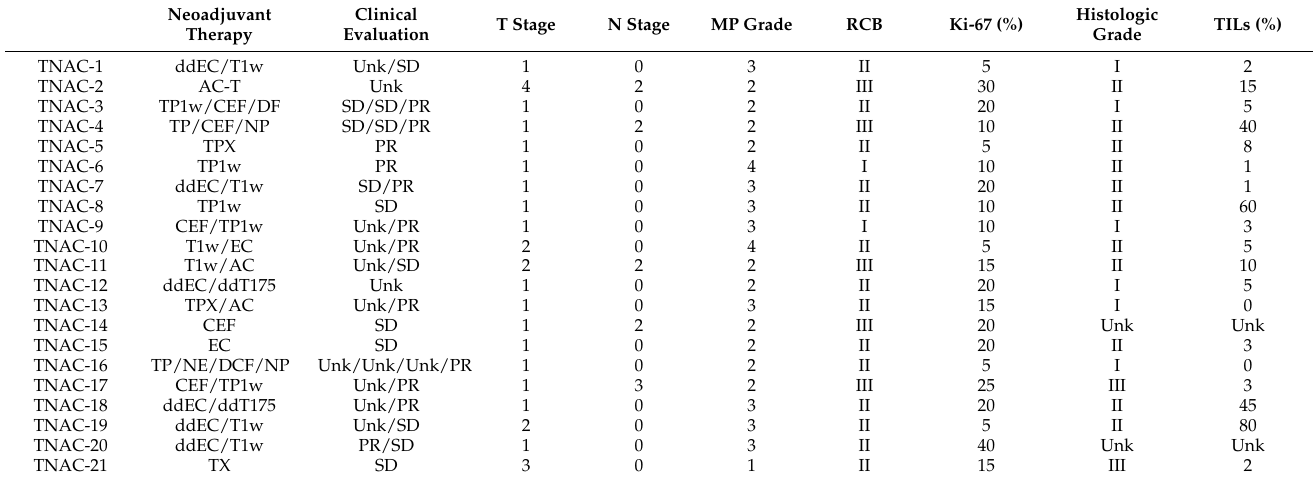
Figure 3. Paired Miller–Payne grading ( A ) and Residual Cancer Burden grading ( B ) of the study cohort. TNAC cases are plotted with red dots and TNBC-NA cases are plotted with green triangles. Each TNAC and TNBC-NA pair is connected with a black line. MP grade system is based on a 5-point scale system with point 5 indicating complete response and point 1 indicating no response. RCB index divided the residual disease into four categories: RCB-0 (pCR), RCB-I (minimal residual disease), RCB-II (moderate residual disease) and RCB-III (extensive residual disease). Statistical analysis was performed with a one-sided paired Wilcoxon test. Table 3. Clinical information of TNAC patients who received neoadjuvant